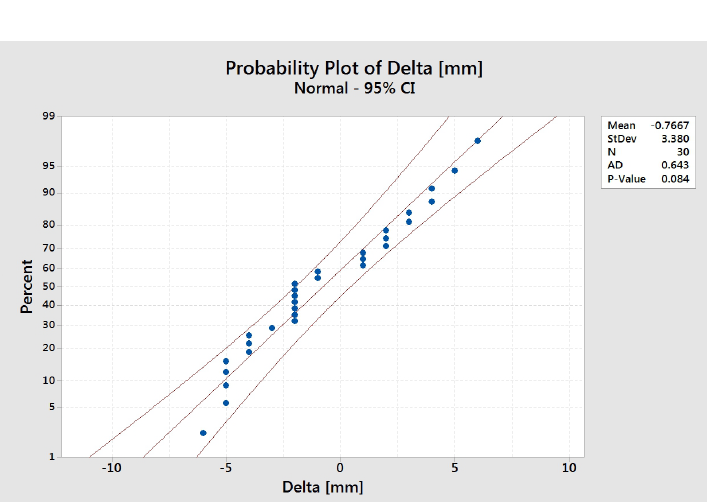
Figure 5. Normal probability plot for the error